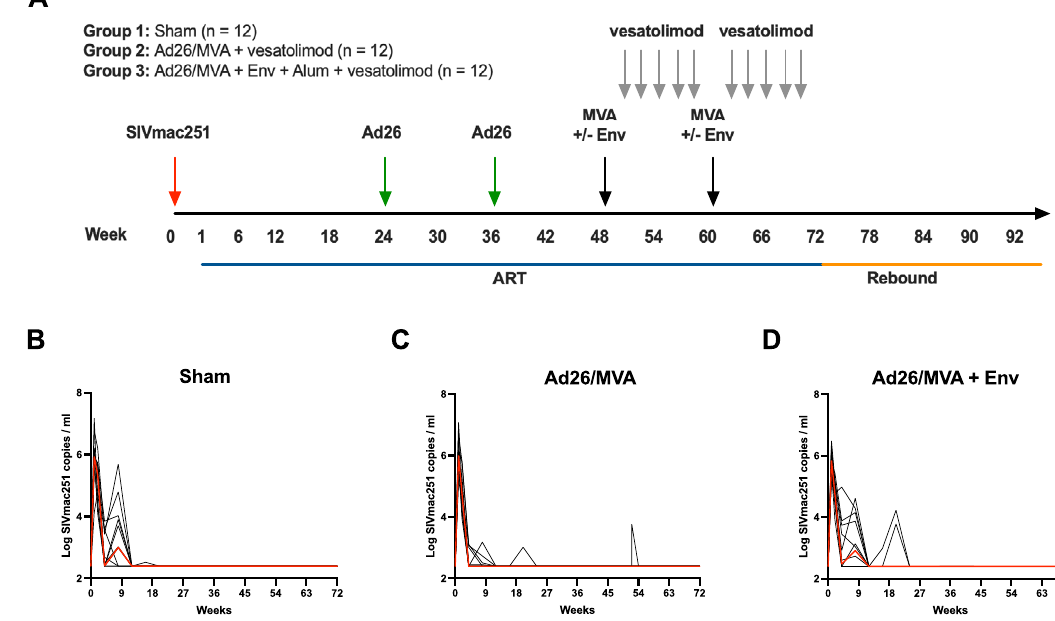
Fig. 1 Ad26/MVA + Env protein subunit boost therapeutic vaccine strategy with vesatolimod treatment. A Therapeutic vaccine study design. B – D Log transformed plasma SIV mac251 viral loads (gag copies/ml plasma) from onset of infection to week 72 post-infection. Limit of detection (LOD) for the SIV viral load qRT-PCR assay used in the study was >250 gag copies/ml plasma. Red lines denote median values across all time